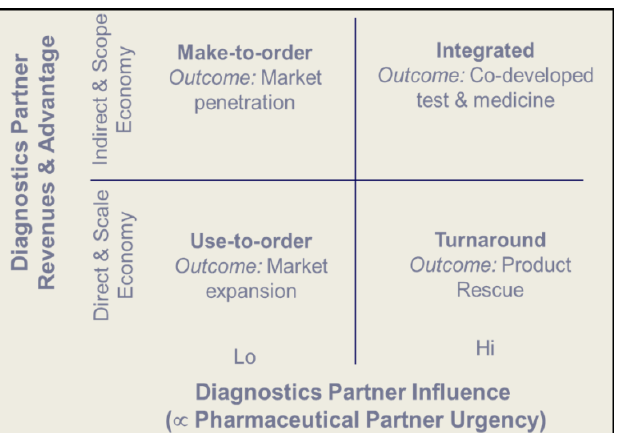
Figure 2. Rx-Dx Model Relationships. Adapted with permission from Blair E.D. (2010)